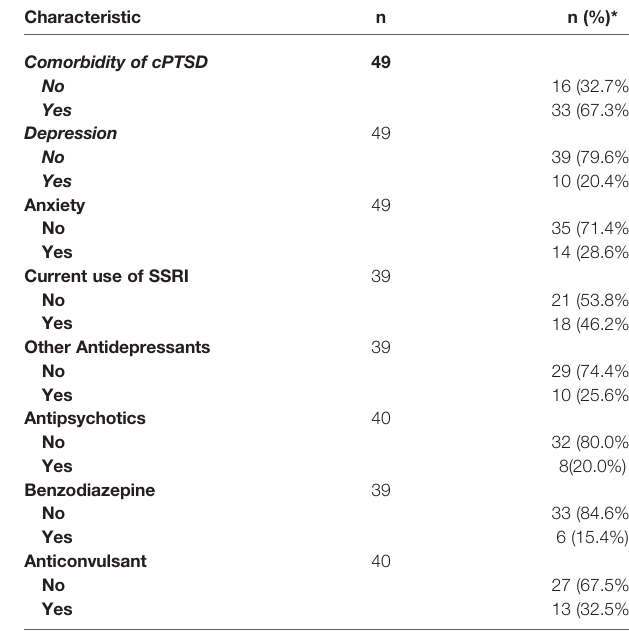
TABLE 2 | Participant clinical